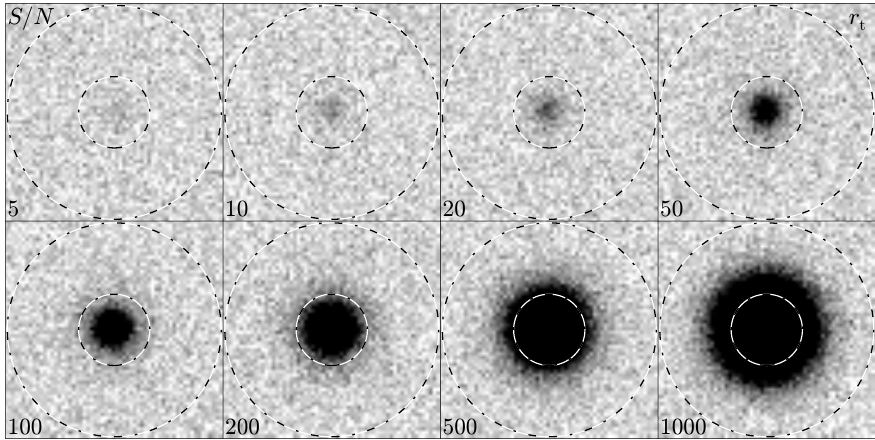
Fig. 1. Examples of simulated star clusters placed in the sky background µ sky = 10 3 ADU. The signal to noise ( S/N ) values (5, 10, 20, 50, 100, 200, 500, and 1000) are displayed in the panels. Inner circle of r phot = 10 pix indicates the photometric aperture used to define the S/N within it. Outer circle indicates the tidal radius r t = 30 pix ( r c = 3 pix). Grey levels correspond to pixel values from 950 to 1250 ADU in linear scale. The cluster’s center with S/N = 1000 has a value of ∼ 41000 ADU. tidal radius r t = 30 pix, shown as the outer circle, are still dominated by the